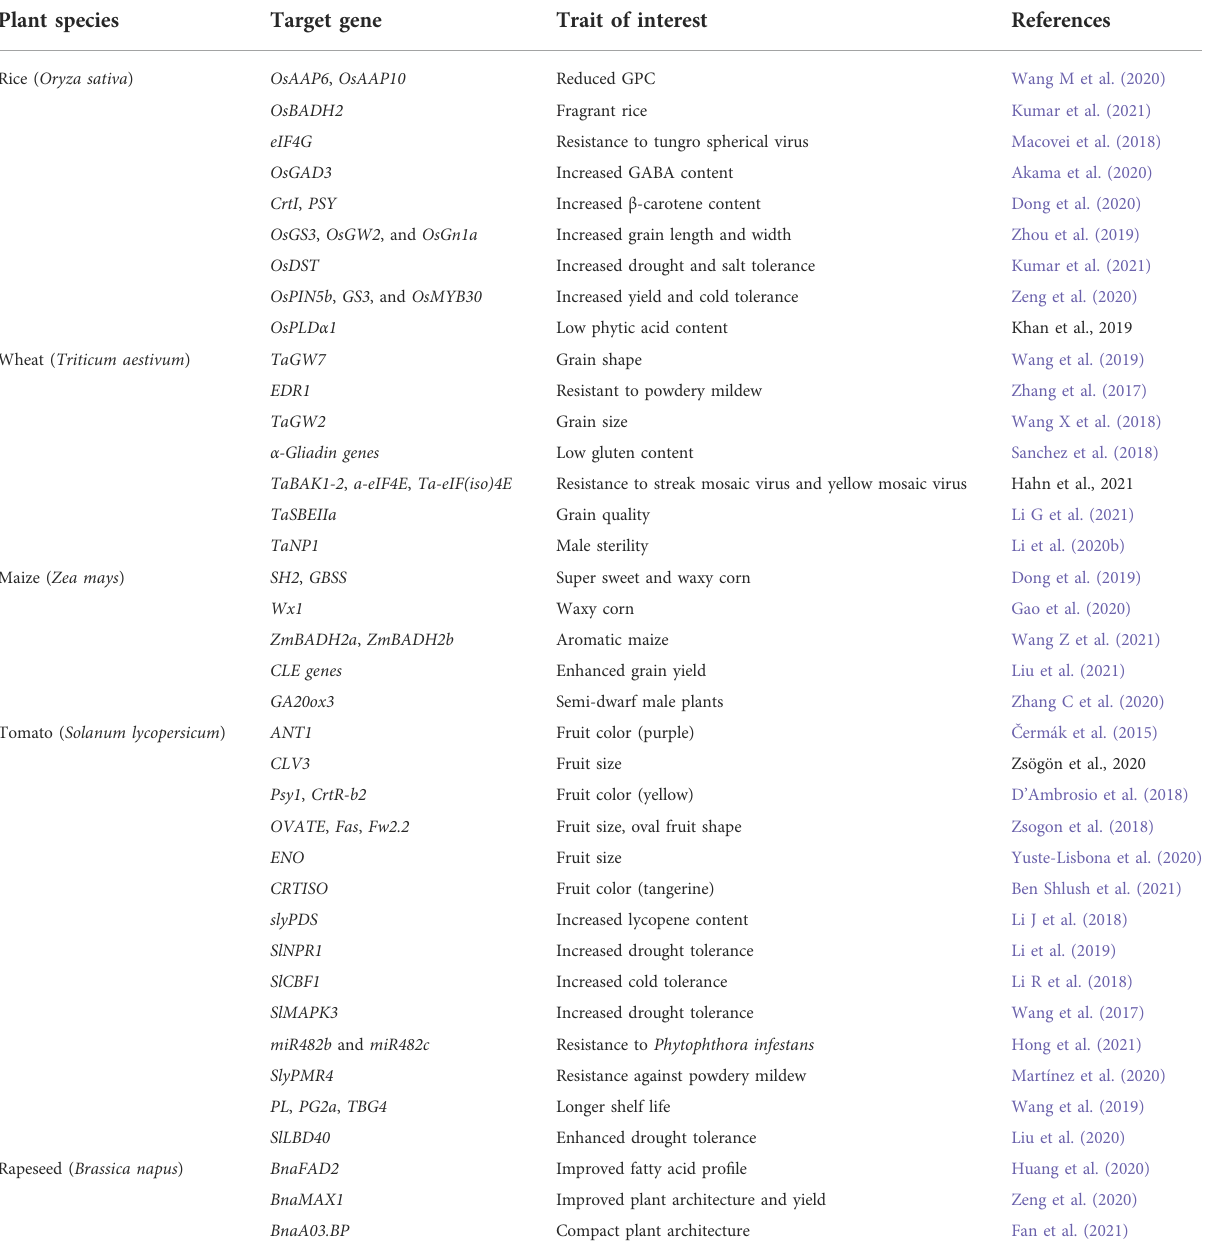
TABLE 2 CRISPR/Cas9-mediated improvement in major crop